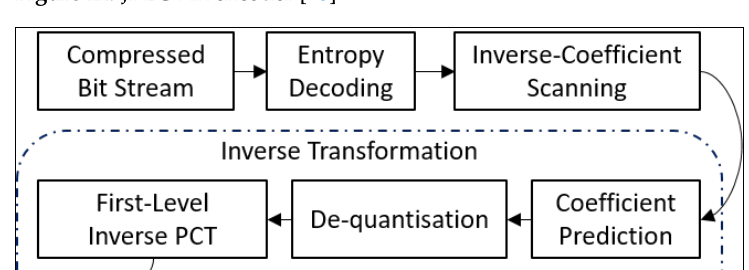
Figure 12. JPEG XR encoder [78].